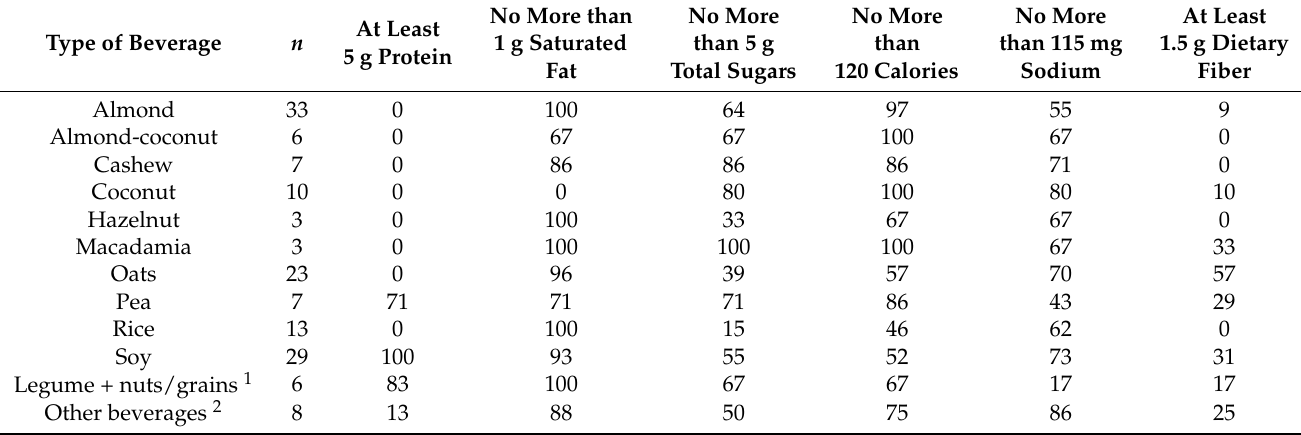
Table 5. Percentage of non-dairy beverages meeting the suggested nutrient guideline per serving, by type of beverage.